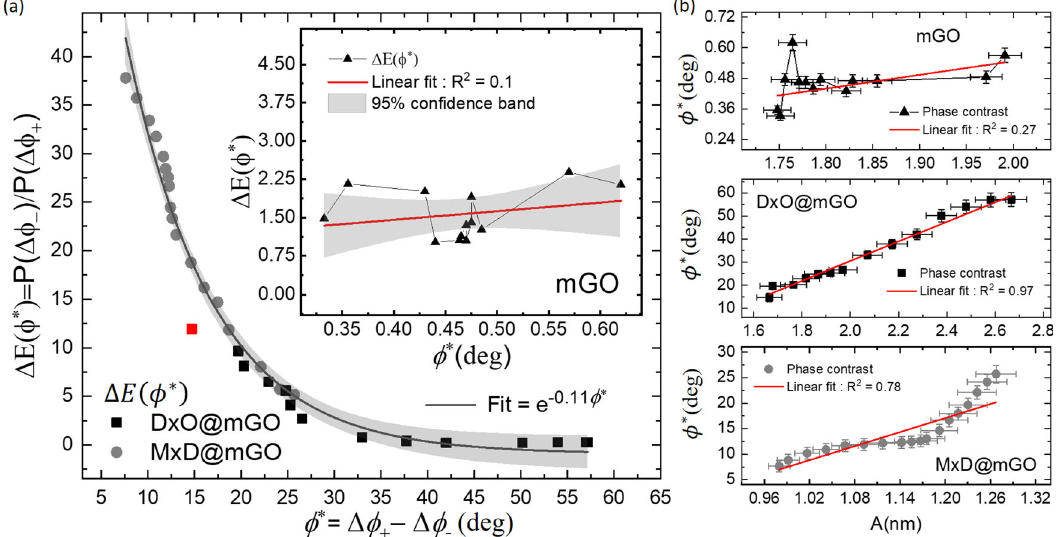
Fig. 6 Energy partitioning and apparent phase-contrast. a The ratio of fl uctuational probability density as a function of apparent phase contrast ϕ (cid:1) . The shaded area represents 95% con fi dence bands of the fi ts. The error bars in the probability estimates are in the order of less than 1%, computed from the area standard deviations of the phase histograms obtained at each amplitude setpoint. The red square denotes a sole outlier of the experimental fi t. b Highlights the evolution of apparent phase-contrast as a function of the tapping amplitudes. The nonlinear behavior observed for DxO and MxD is indicative of inelastic deviations yielding to viscous relaxations at the heterogeneities. The error bars in the apparent phase contrast ϕ (cid:1) are obtained from the standard deviations of measured phase histograms and the dynamic amplitude A